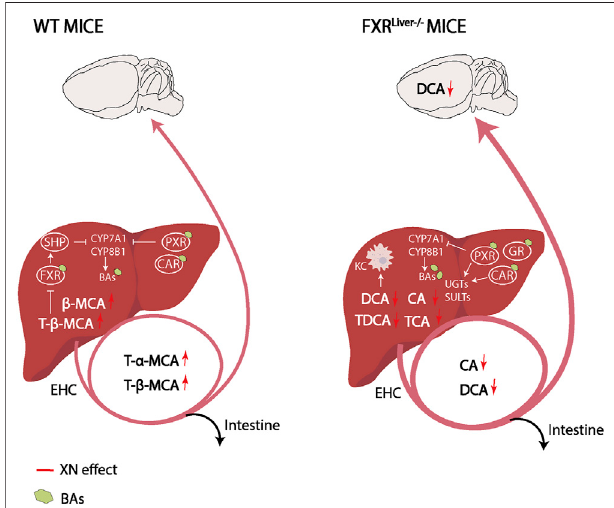
FIGURE 7 | Working hypothesis on XN mechanism of control of BA synthesis and detoxi fi cation in WT and FXR Liver − / − mice. XN promotes BA synthesis in WT mice and increases FXR antagonists in the liver and plasma. This results in downstream expression of enzymes involved in BA synthesis, CYP7A1 and CYP8B1. Negative feedback on BA synthesis is exerted by BAs agonists of FXR, PXR and CAR. Compared to WT mice, FXR Liver − / − mice had increased BA synthesis, bigger BA pool sizes and increased passage of BAs through the BBB. In FXR Liver − / − mice, BAs such as CA and DCA impair hepatic Kupffer cells (KCs) activity, which XN might attenuatebydecreasingCAandDCAconcentrations.XN-mediatedactivation of PXR and CAR, and GR slows down de novo BA synthesis by inhibition of CYP7A1 and induces metabolizing enzymes to stimulate BA excretion. Abbreviations: EHC (Enterohepatic circulation), KC (Kupffer